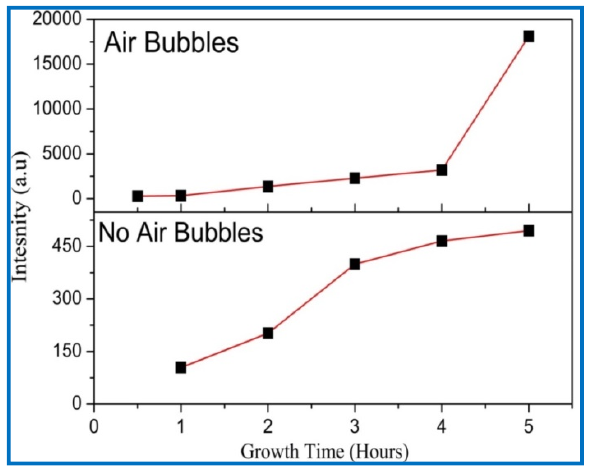
Figure 9. Growth time versus intensity of ZnO NRs of diffraction peak (002) plane when no air bubbles are present and when air bubbles are present.